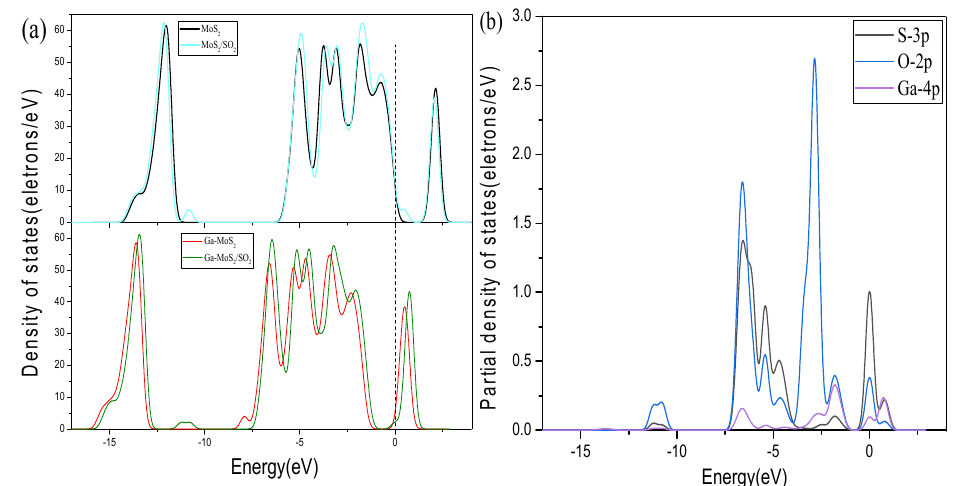
Figure 9. Comparative analysis of ( a ) DOS and ( b ) PDOS for SO 2 system. The dotted lines are Fermi level.